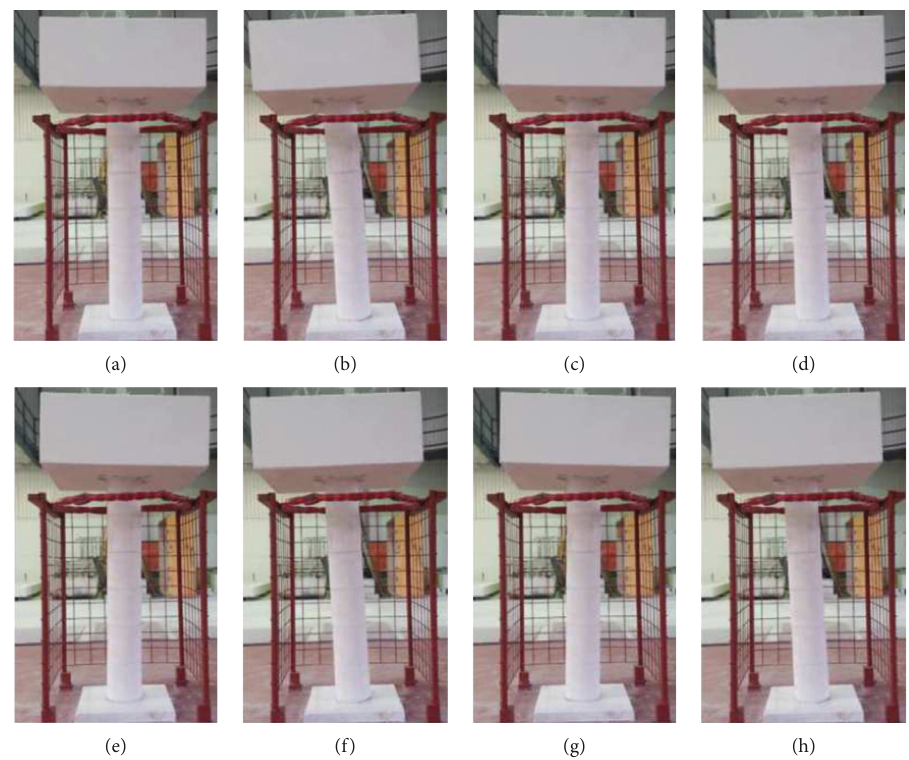
Figure 14: Appearance of the column S6m for the Ston accelerogram at a (c) t � 5.5 s, (d) t � 6.2s, (e) t � 7.0s, (f) t � 7.9s, (g) t � 8.9s, and (h) t �